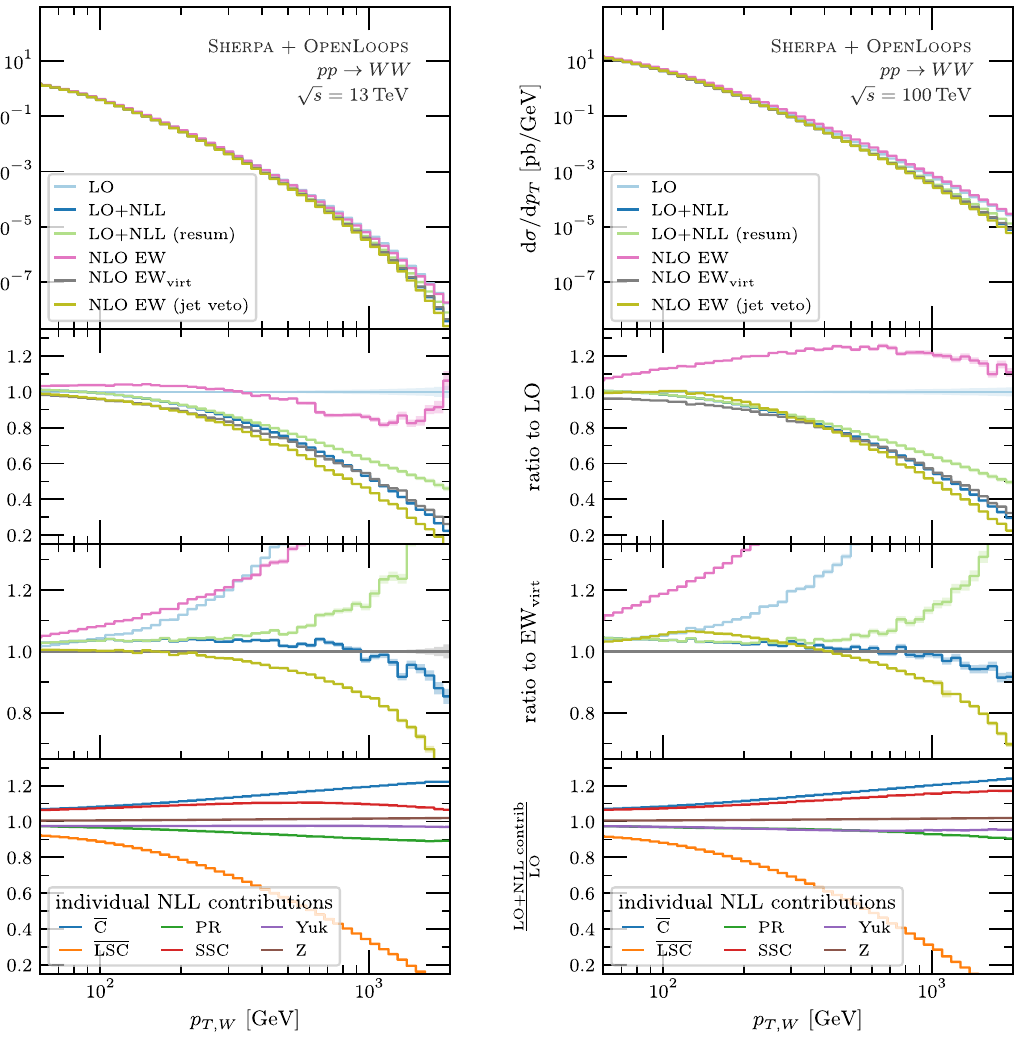
Fig. 2 The transverse momentum of the individual W bosons in W rections are resummed (“LO+NLL (resum)”). In addition, the virtual approximation EW virt and a variant of the NLO EW calculation with boson pair production from proton–proton collisions (including pho- √ s = 13TeV (left) and 100TeV (right). The ton induced channels) at additional jets vetoed are also included. The ratio plots show the ratios to the LO and to the EW virt calculation, and the relative size of each baseline LO and NLO EW calculations are compared with the results of the LO+NLL calculation and its variant, where the logarithmic cor- NLL